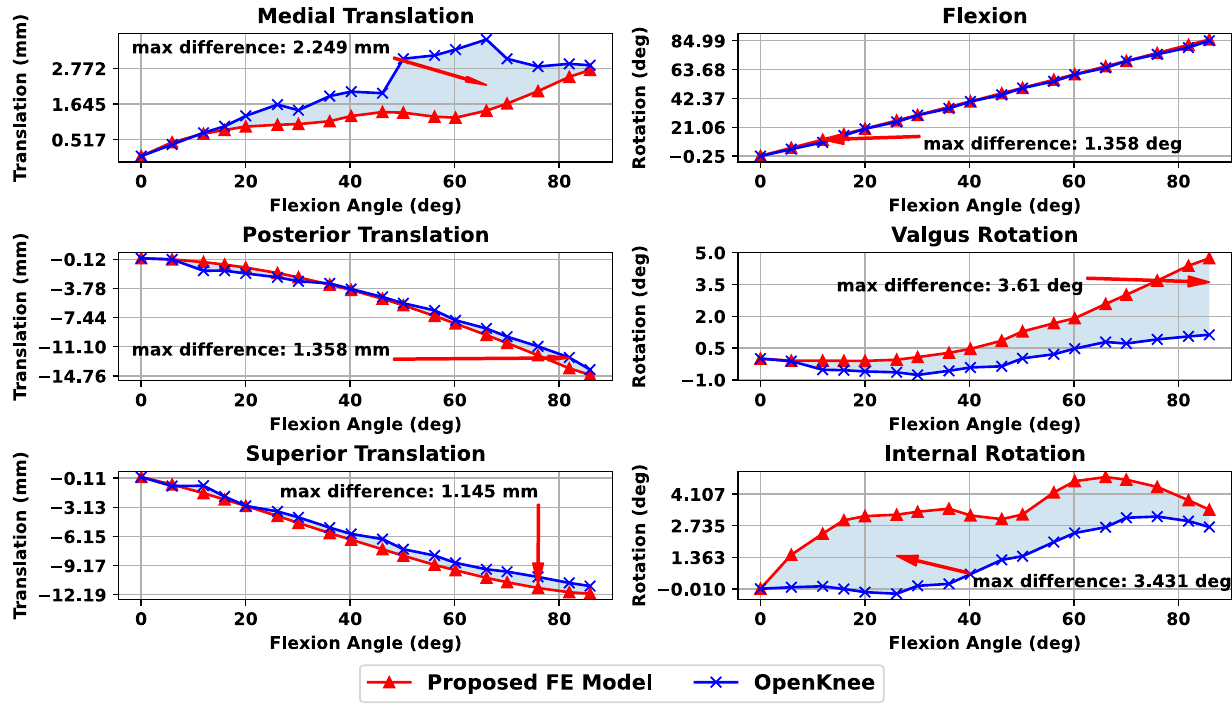
Figure 6. Comparison of simulated and experimental kinematics during passive knee flexion (translations left and rotations right). We observe that the proposed FE model exhibits comparable performance for the translations except for the medial-lateral direction. Regarding rotations, different behavior is evident for the internal-external rotation with a good initial match during varus-valgus rotation.